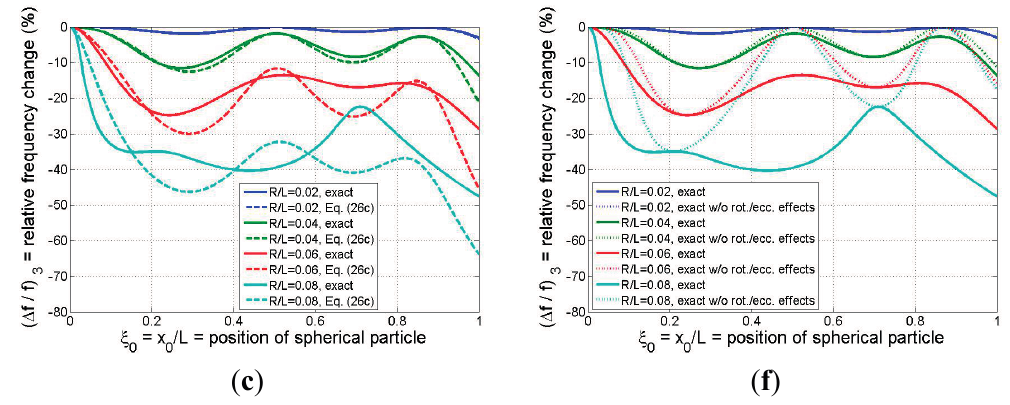
Figure 6. Relative frequency shift for the first three modes as a function of binding position of a solid spherical adsorbate: ( a )–( c ) (left column) exact model vs. refined analytical formula; ( d )–( f ) (right column) exact model with and without the effects of the adsorbate’s rotational inertia and eccentricity. R = radius of spherical particle (system parameters: ρ sphere / ρ beam =1, L 2 / bh =